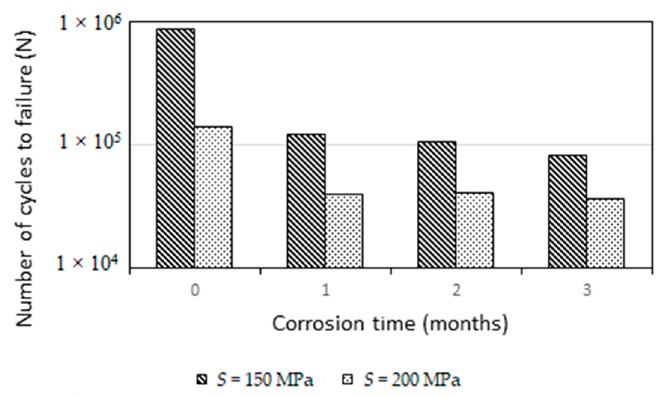
Figure 8. Number of cycles to failure ( N ) vs. corrosion time ( t ). Data were calculated from the Basquin equation for ∆ S = 200 MPa (dark) and ∆ S = 100 MPa (light).